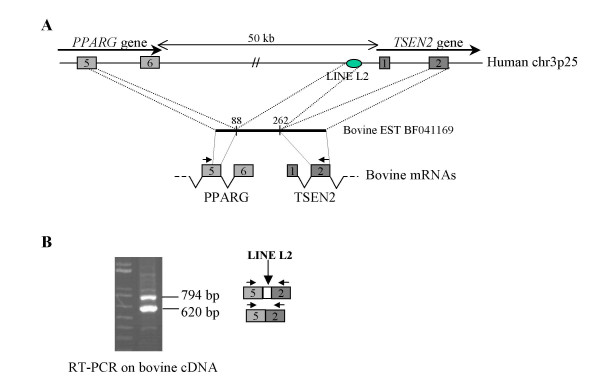
Identification of chimeric transcripts between the bovine PPARG and TSEN2 genes. A-Correspondance between the bovine EST BF041169 and human chr3p25 genomic sequence and bovine mRNAs. B- RT-PCR experiment performed on bovine cDNA using primers designed on PPARG exon 5 and TSEN2 exon 2: structure of the two amplified fragments.